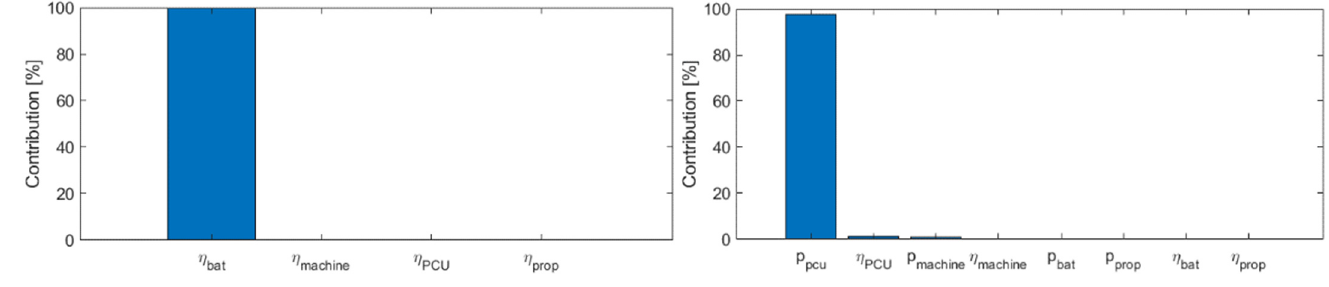
Figure 15. Variance analysis of all-electric powertrain.